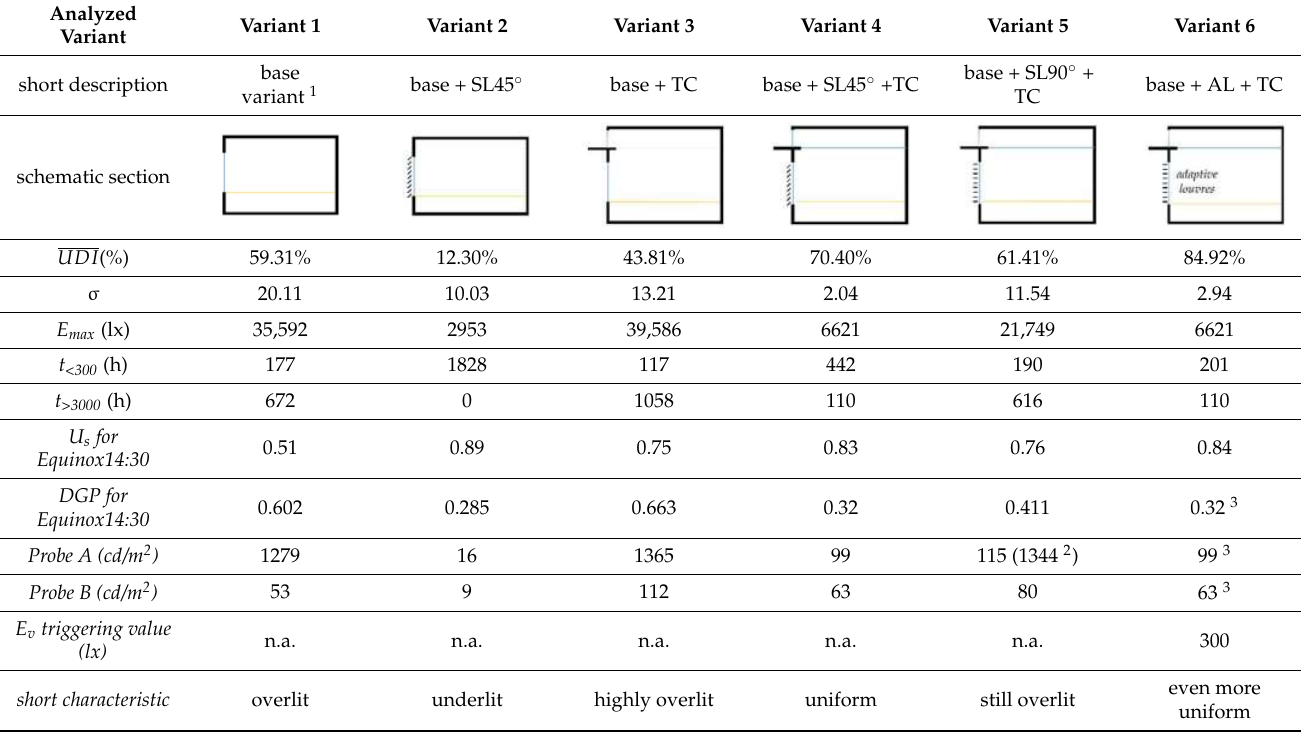
Table 3. The results of the computer simulation of all analyzed